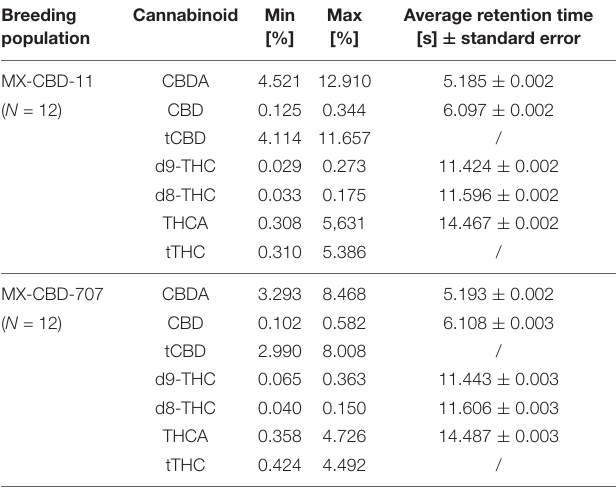
TABLE 2 | Concentrations of CBDA, CBD, tCBD, THCA, d8-THC, d9-THC, and tTHC (in % w/w) measured in dried inflorescences of breeding populations MX-CBD-11 and